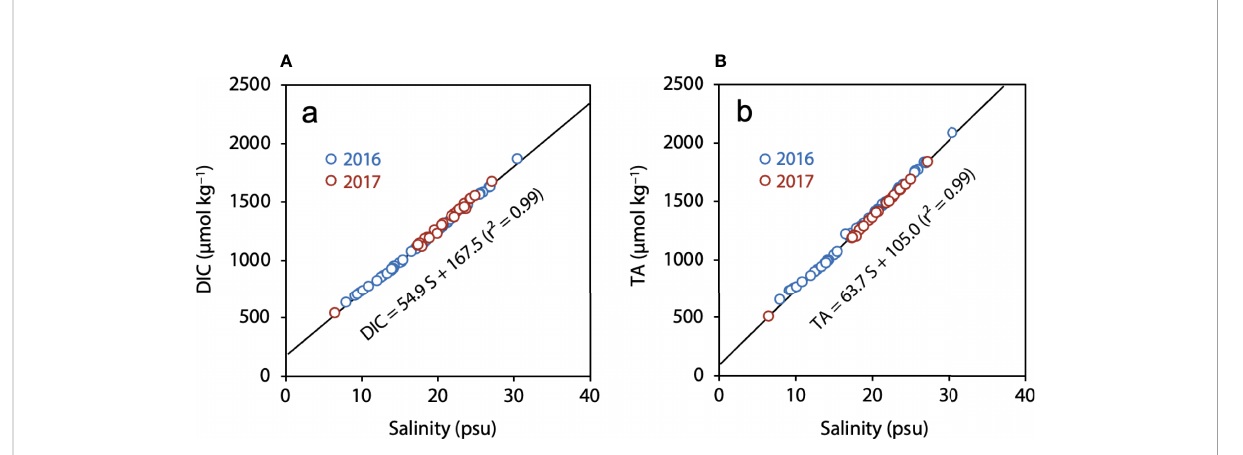
FIGURE 4 Relationships between (A) DIC, (B) TA and salinity.